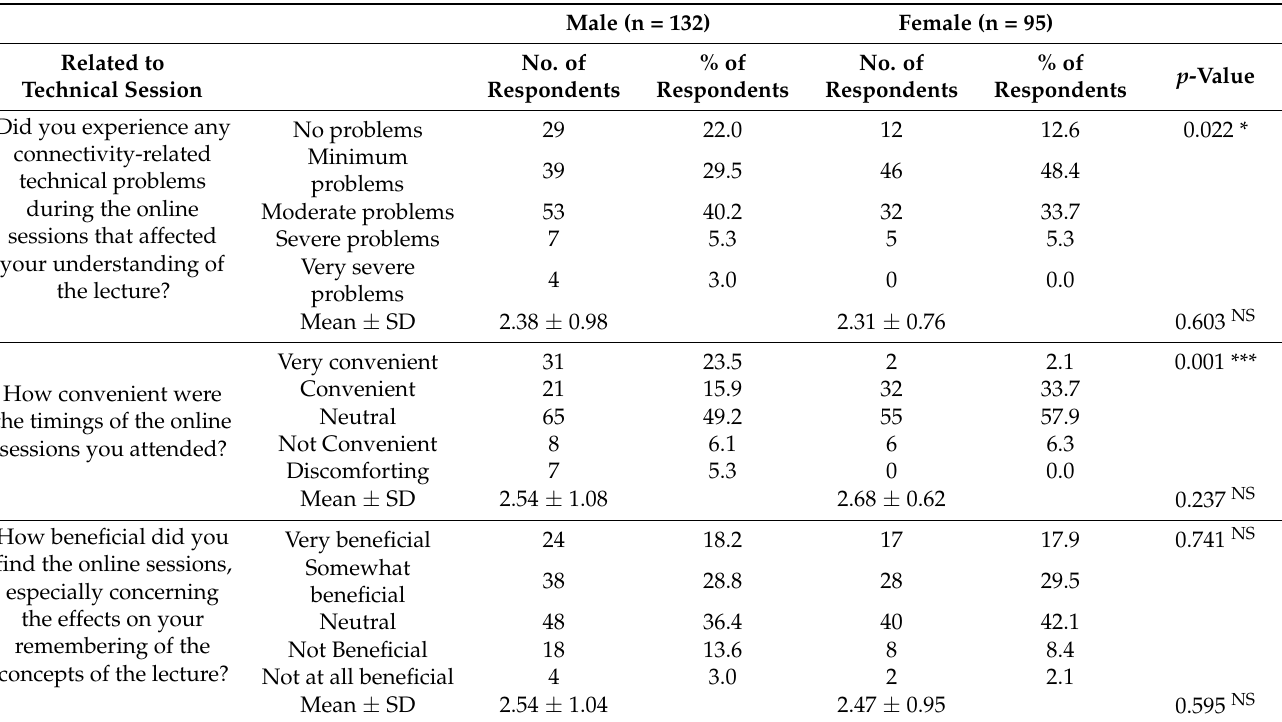
Table 7. Distribution of responses related to technical sessions according to